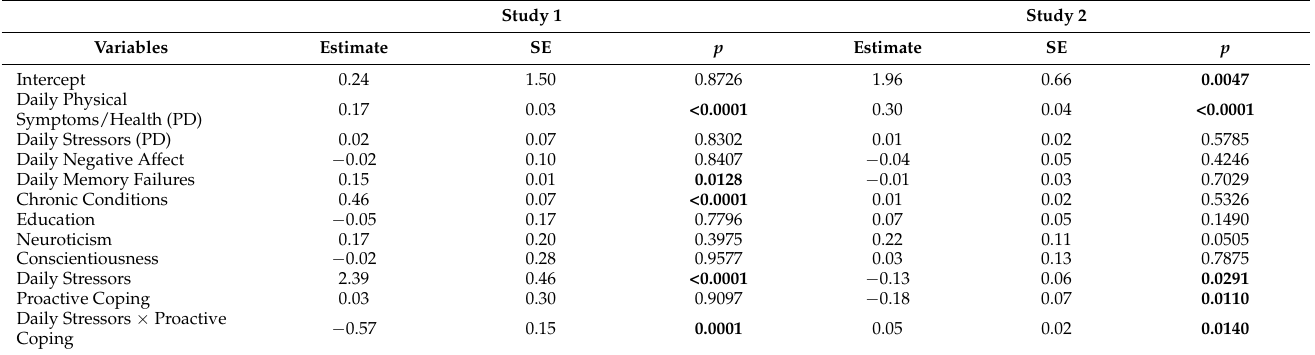
Table 4. Younger Adult